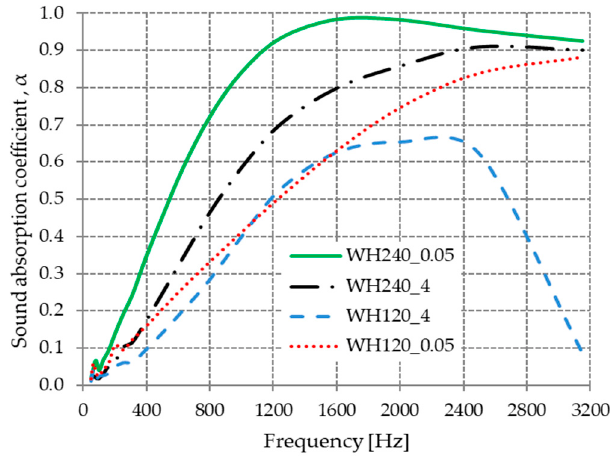
Figure 8. Variation in the acoustic absorption coefficient with the compaction pressure.